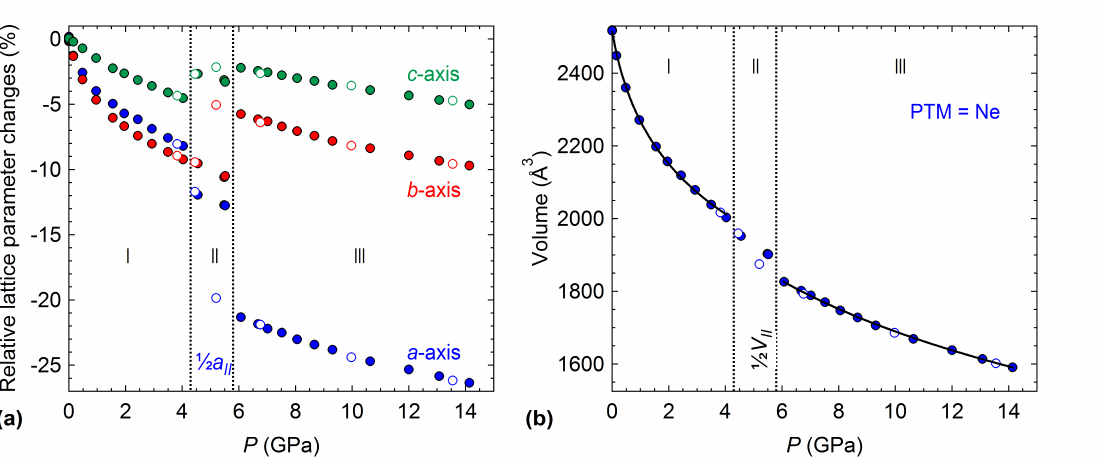
Figure 6. Pressure dependence of ( a ) the relative changes in lattice parameters of 4HCB with neon as the PTM, and ( b ) the unit cell volume, with the solid black lines indicating third-order Vinet equation of state fits. Transition points are shown by the dotted black lines, and the different phases are indicated by I, II, and III. The a -axis and the volume have been halved in phase II to be comparable to phases I and III. Decompression points are indicated by the open